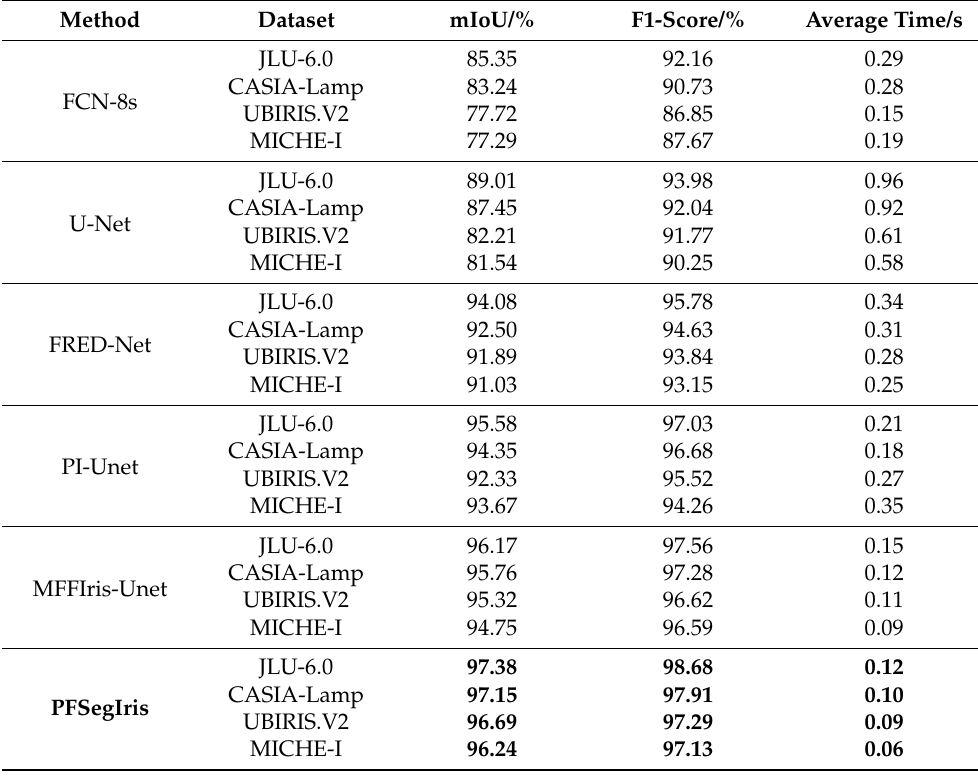
Table 5. The evaluation indexes of different algorithms on four iris datasets.